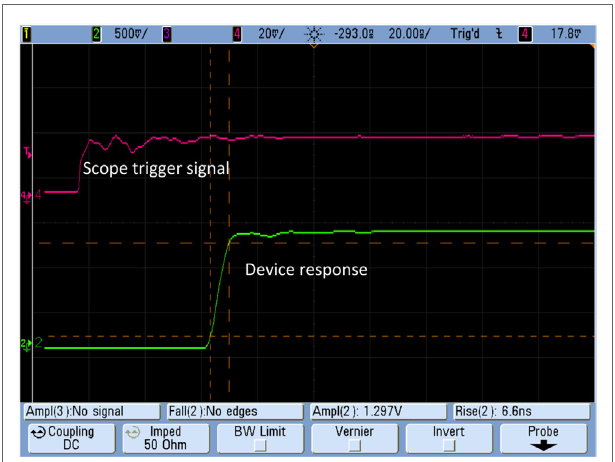
FiGURe 11 | Detector pulse response at − 3 v bias voltage: showing 6.6 ns rise time .